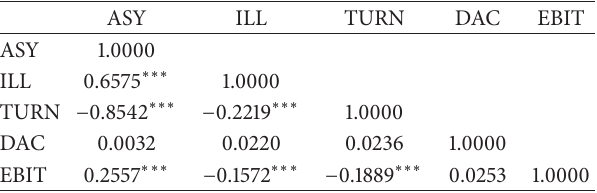
Table 1: Raw information asymmetry correlation